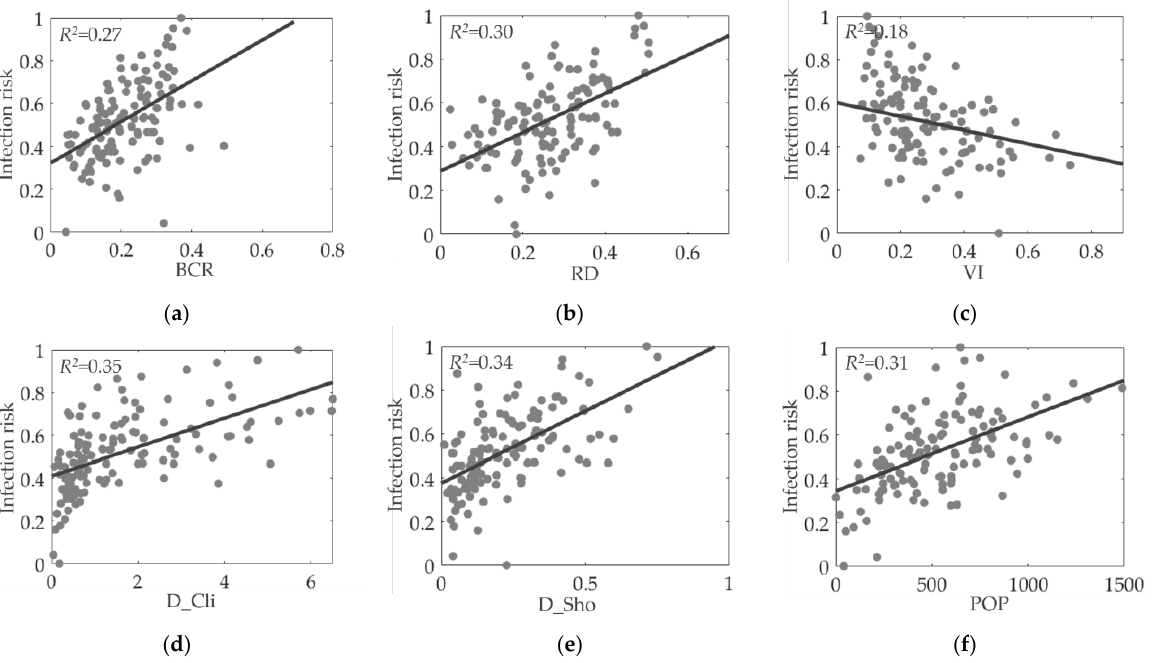
Figure 7. Impact of urban environment features on COVID-19 infection rate in Hong Kong: ( a ) Building coverage ratio; ( b ) Road density; ( c ) Vegetation index; ( d ) Density of clinics; ( e ) Density of shops; ( f ) Population.